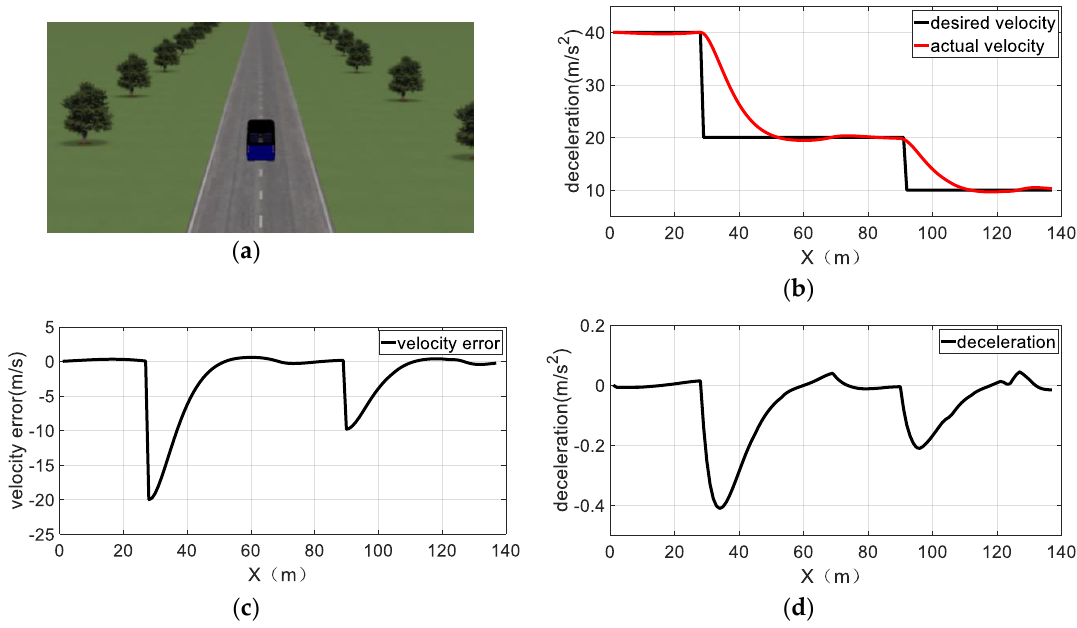
Figure 18. Longitudinal control simulation results. ( a ) Simulate scene. ( b ) Desired velocity and actual velocity. ( c ) Velocity error. ( d ) Deceleration of the driverless bus.